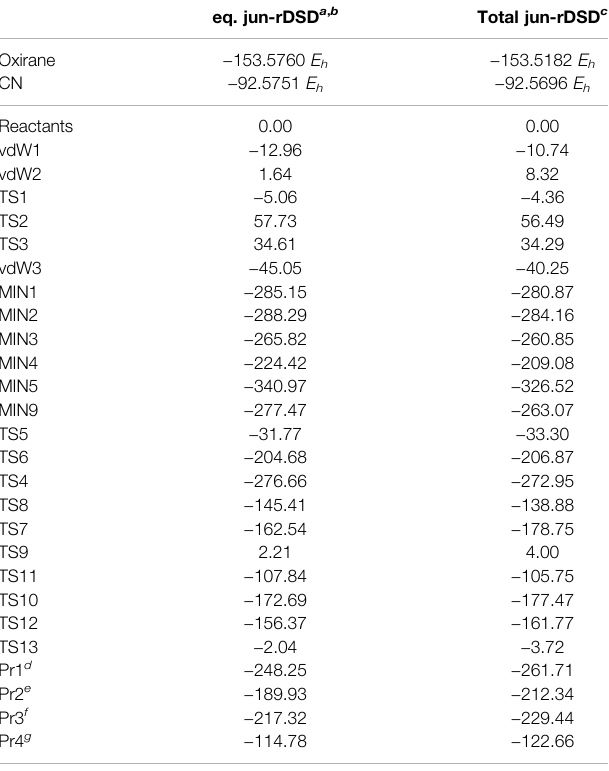
TABLE 1 | Equilibrium and ZPE-corrected relative energies for the most relevant stationary points located on the PES and reported in Figure 1 . For completenesstheabsoluteenergies (inHartree units)ofthetworeactants arealso